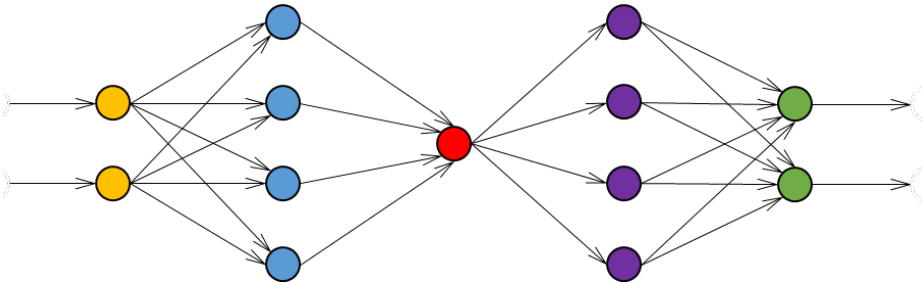
Figure 2. Typical AE architecture, with input (yellow), encoding (blue), bottleneck (red), decoding (purple), and output (green) layers [20].